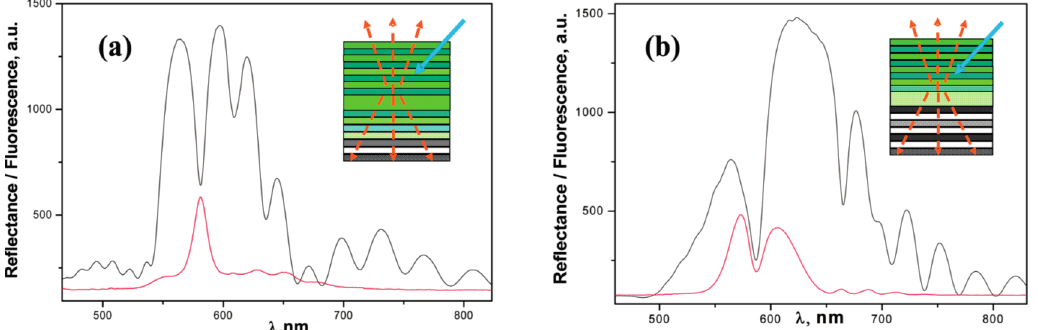
Figure 3. Reflectance (black) and fluorescence (red) of PSi MC infiltrated with Poly(2-methoxy-5-(2-ethylhexyloxy)-1,4-phenylenevinylene) (MEH-PPV) with a top ( a ) low porosity layer and ( b ) high porosity layer. Insets depict ( a ) deep and ( b ) shallow infiltration resulting in a resonance fluorescence peak and spectral “hole,” respectively (blue arrow—excitation light; yellow arrows—fluorescence; green color—infiltrated